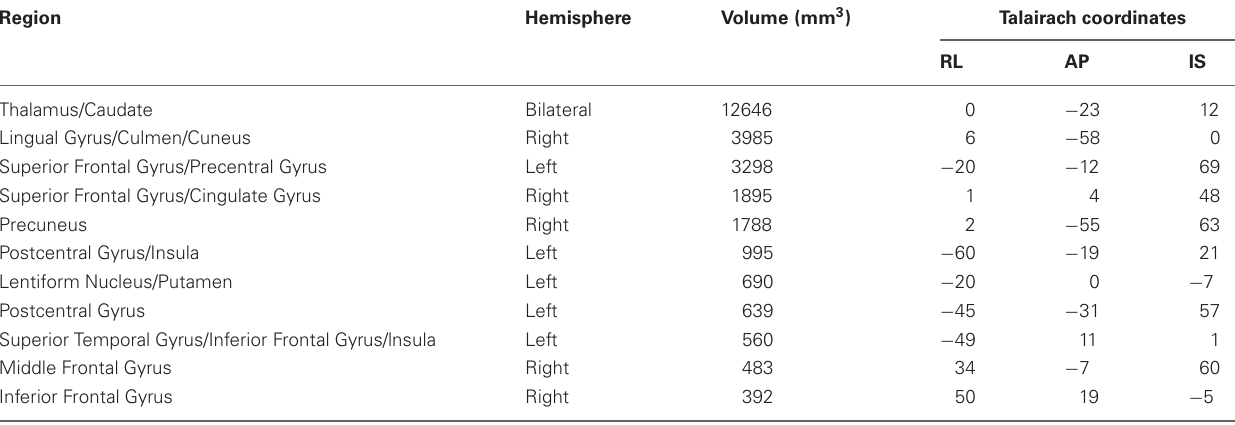
Table 1 | Brain activation during fear conditioning.